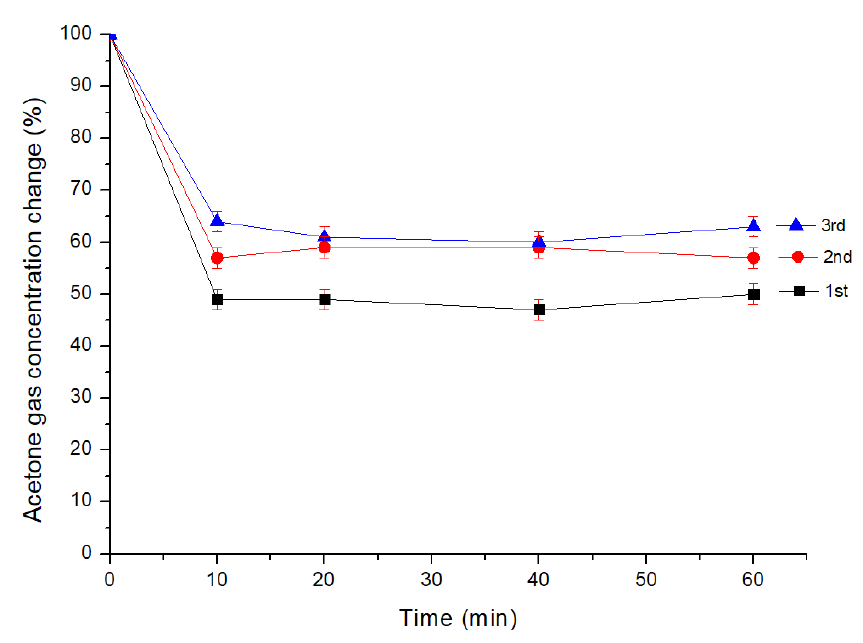
Figure 13. Acetone gas adsorption amount for reuse tests (dg 170% 4-AMP-Cu, 50 ppm) .